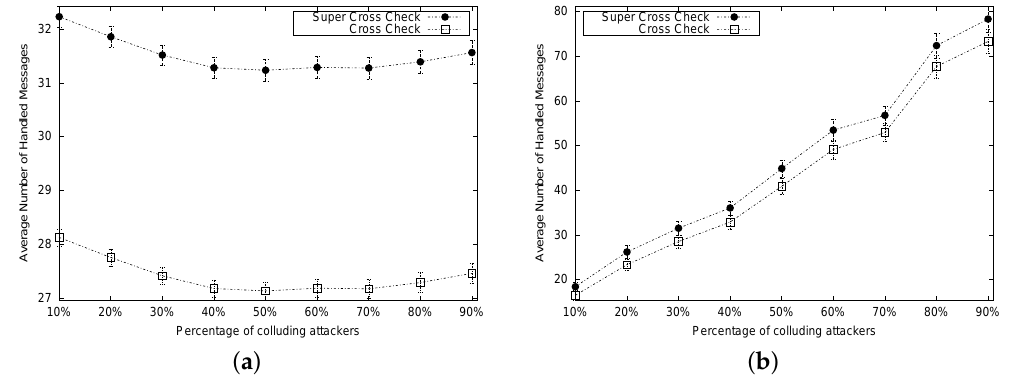
Figure 9. Average cost per algorithm and its 95% confidence intervals. ( a ) Uniform deployment; ( b ) Random